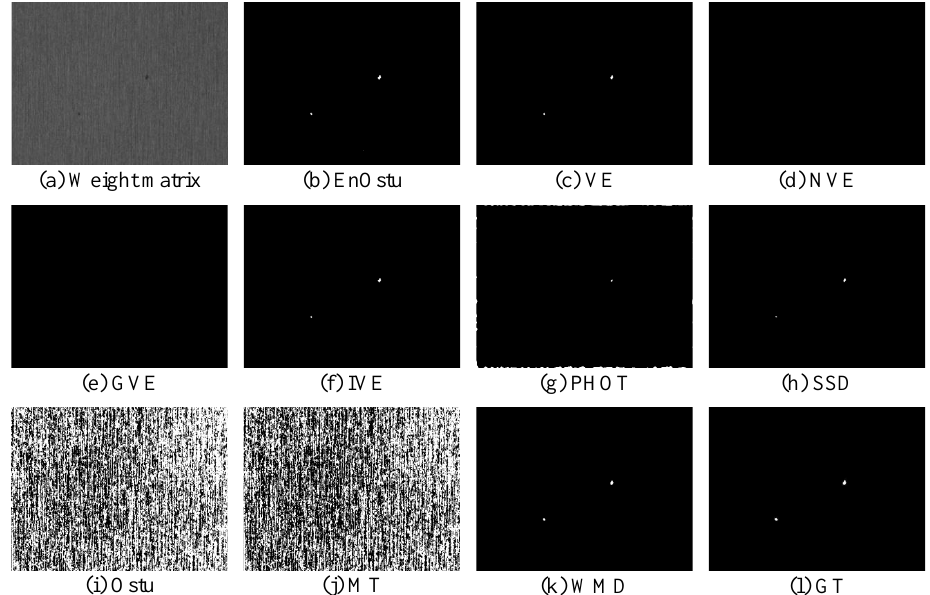
Figure 14. Visual comparisons of detection results using the ten methods on weighed matrix with multiple defects. NVE, GVE, and PHOT cannot effectively identify defects. EnOstu, VE, IVE, SSD, Ostu, MT and our method (WMD) can effectively provide the location of the